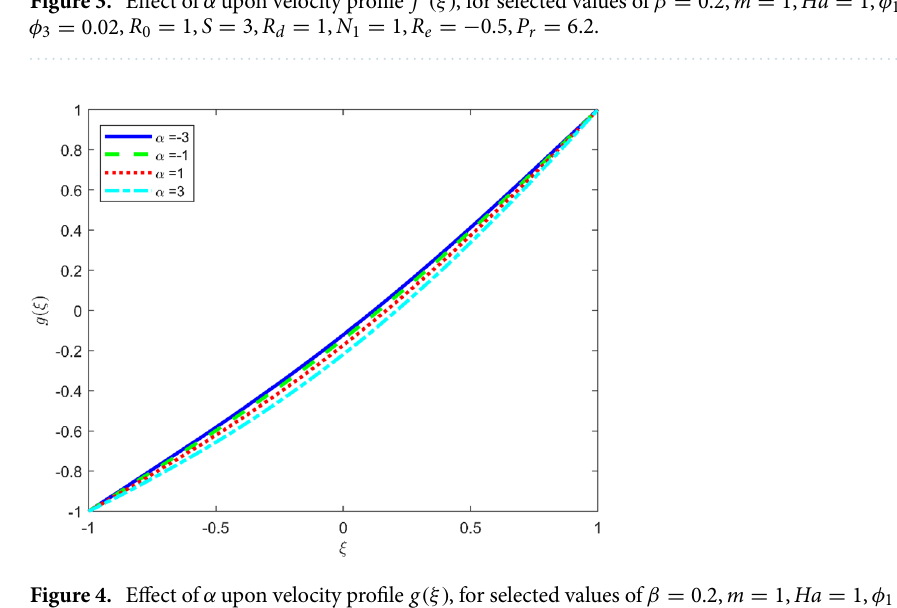
Figure 3. Effect of α upon velocity profile f ′ (ξ) , for selected values of β = 0.2, m = 1, Ha = 1, φ 1 = φ 2 =